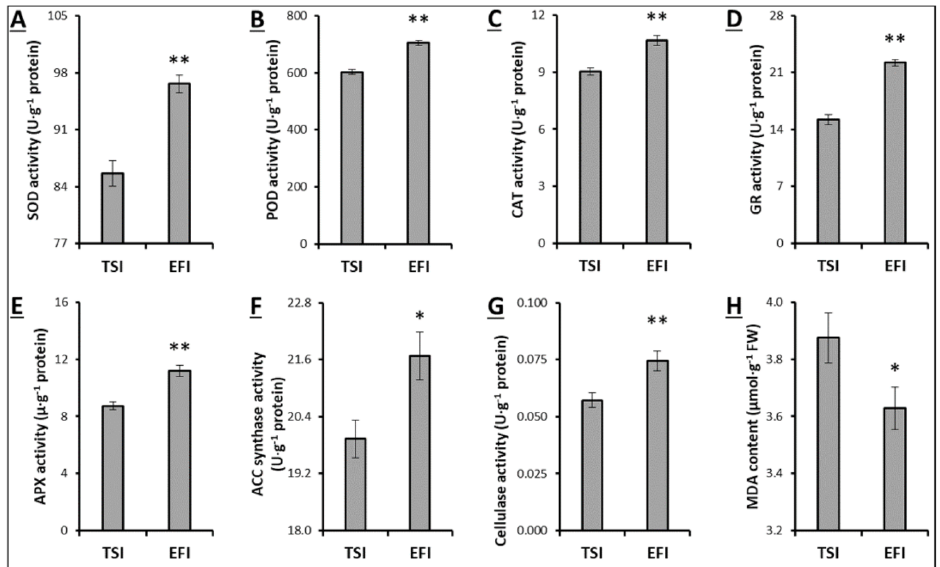
Figure 4. Effect of top sprinkle (TSI) and ebb-and-flow (EFI) irrigation on activities of SOD ( A ), POD ( B ), CAT ( C ), GR ( D ), APX ( E ), ACC synthase ( F ) and callulase ( G ), and MDA content ( H ) of tomato root. Vertical bars indicate means ± SE ( n = 3). The * and ** represent significance at p ≤ 0.05 and p ≤ 0.01, respectively, according to Student’s t -test.